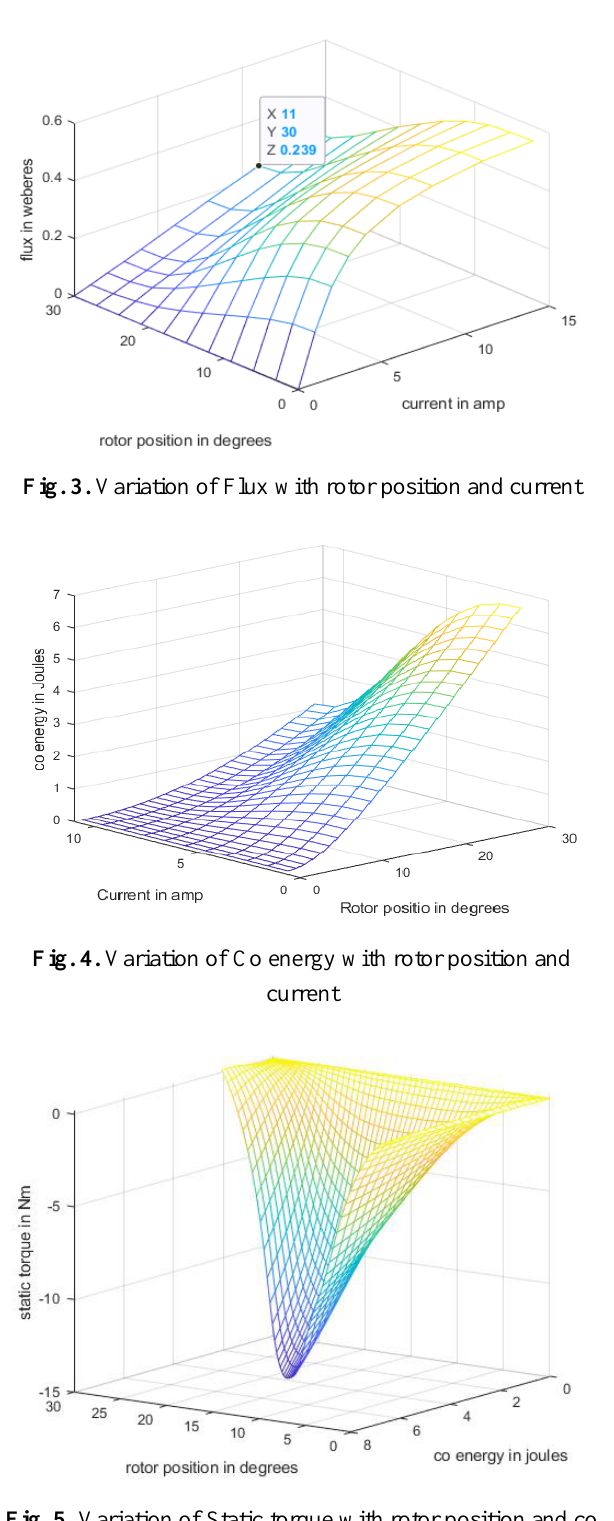
Fig. 5. Variation of Static torque with rotor position and co